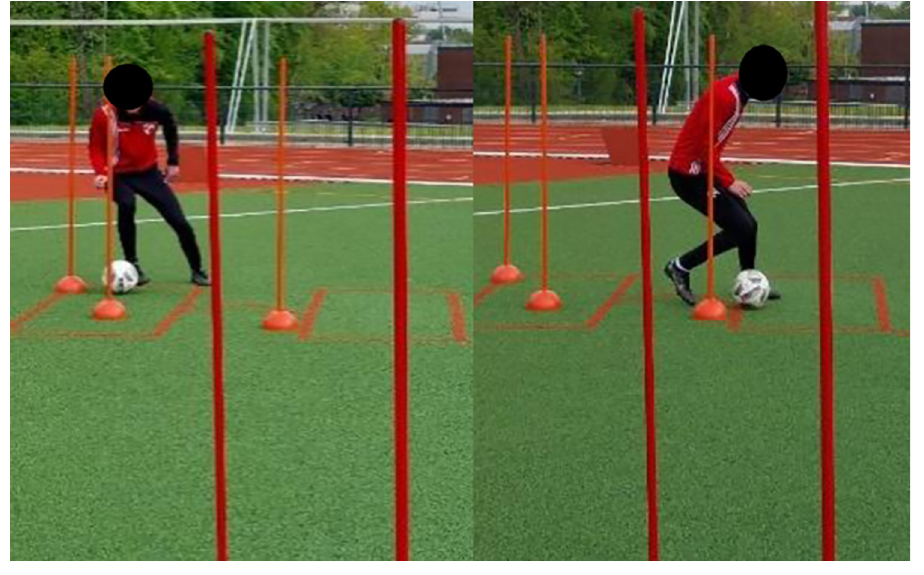
Fig 4. Dribbling